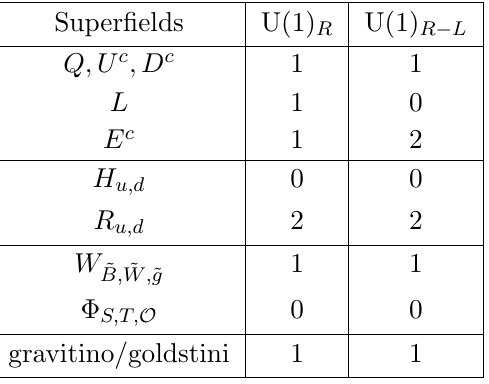
The relevant (cid:12)eld content of the model. (SM charges are not shown.) (cid:8) S;T; O are super(cid:12)elds which has the same SM charges as W ~ and their fermionic components, S; T; are B; ~ W; ~ g O the Dirac partners of the bino, wino and the gluino respectively. The fermionic components of the super(cid:12)elds R u;d are the Dirac partners of the Higgsinos ~ h u;d . well as left-right mixing of sfermions. Hence, e.g., one-loop diagrams that would generate a large electric dipole moment for fermions are suppressed, solving the SUSY CP